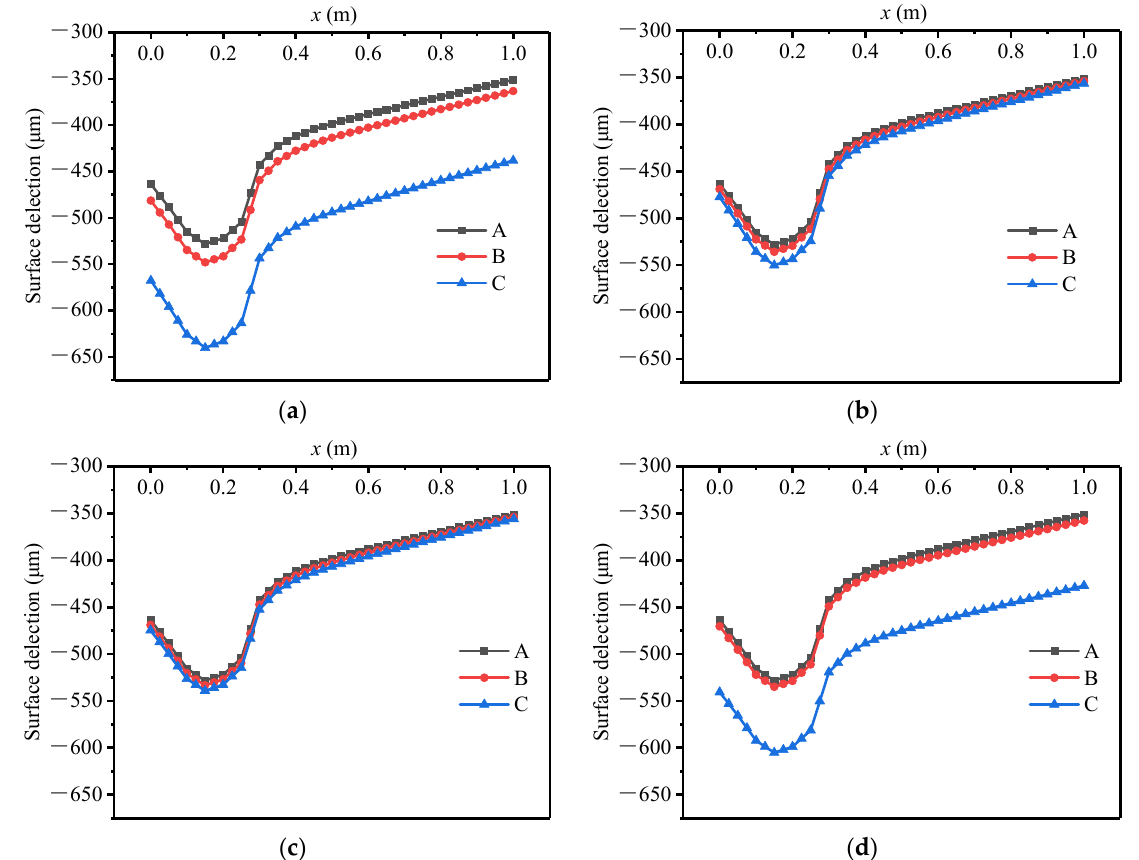
Figure 8. Surface deflections under the anisotropy of different materials: ( a ) Anisotropy in all layers. ( b ) Anisotropy in the HMA layer. ( c ) Anisotropy in the semi-rigid base layer. ( d ) Anisotropy in the subgrade layer. Table 5. The results of the ANOVA of the surface